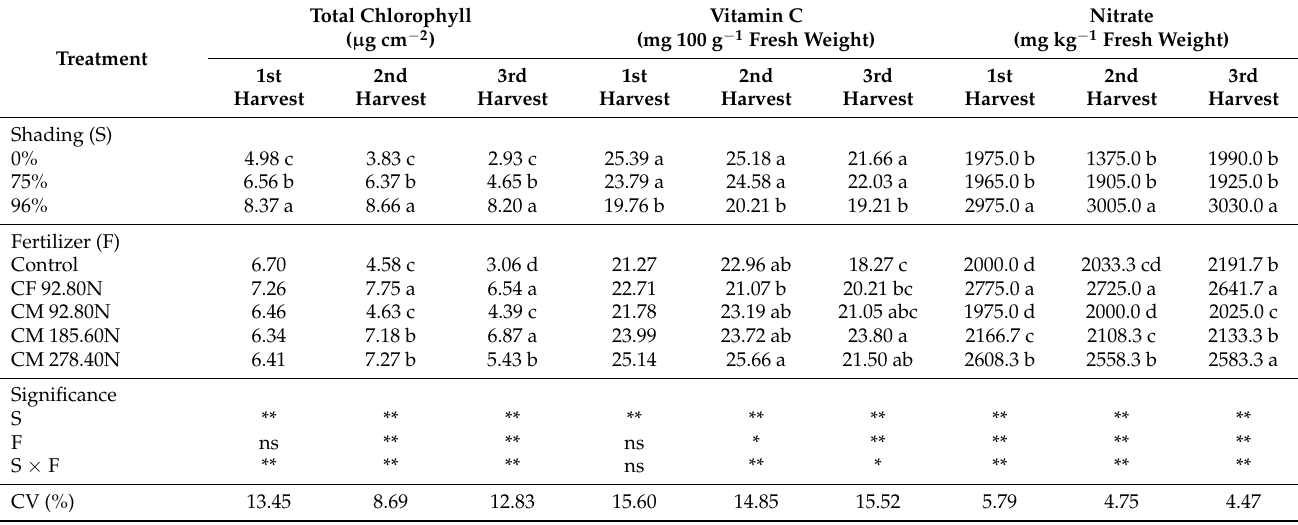
In addition, total chlorophyll content was revealed to be influenced significantly by shading level and fertilization ( p ≤ 0.05). In the first month, the highest total chlorophyll